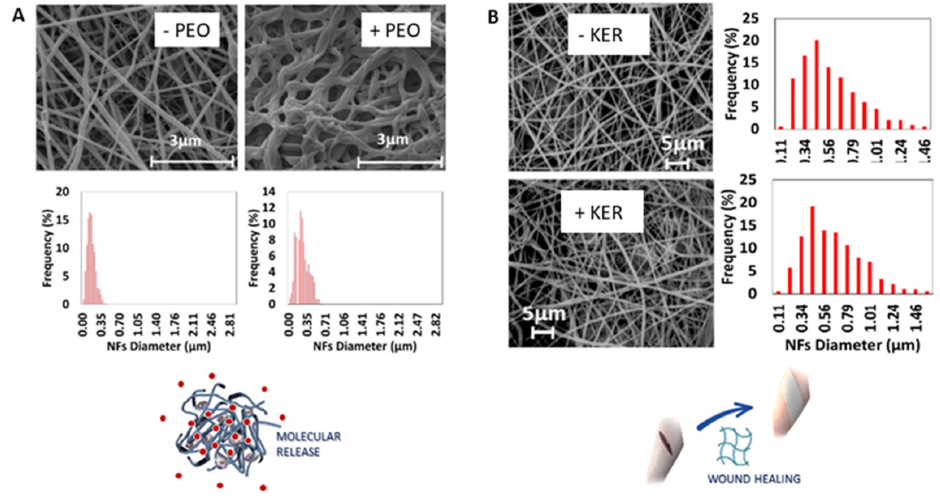
Figure 4. Keratin-based fibers processed via aqueous solvent electrospinning by adding hydrogel-like polymers: ( a ) PEO [78] and ( b ) PVA [79]: Fiber morphology via SEM and diameter distribution. (adapted from [78,79]).